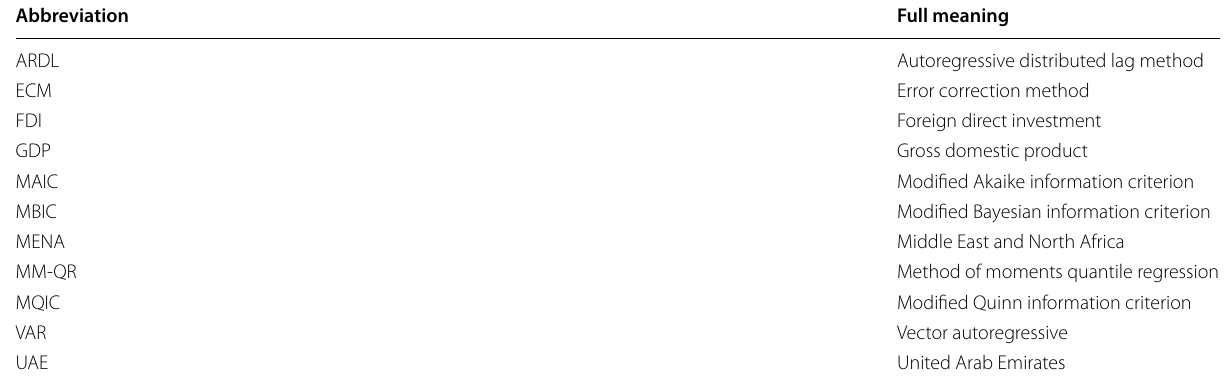
Table 10 Full meaning of abbreviated world Source : Compiled by the Authors